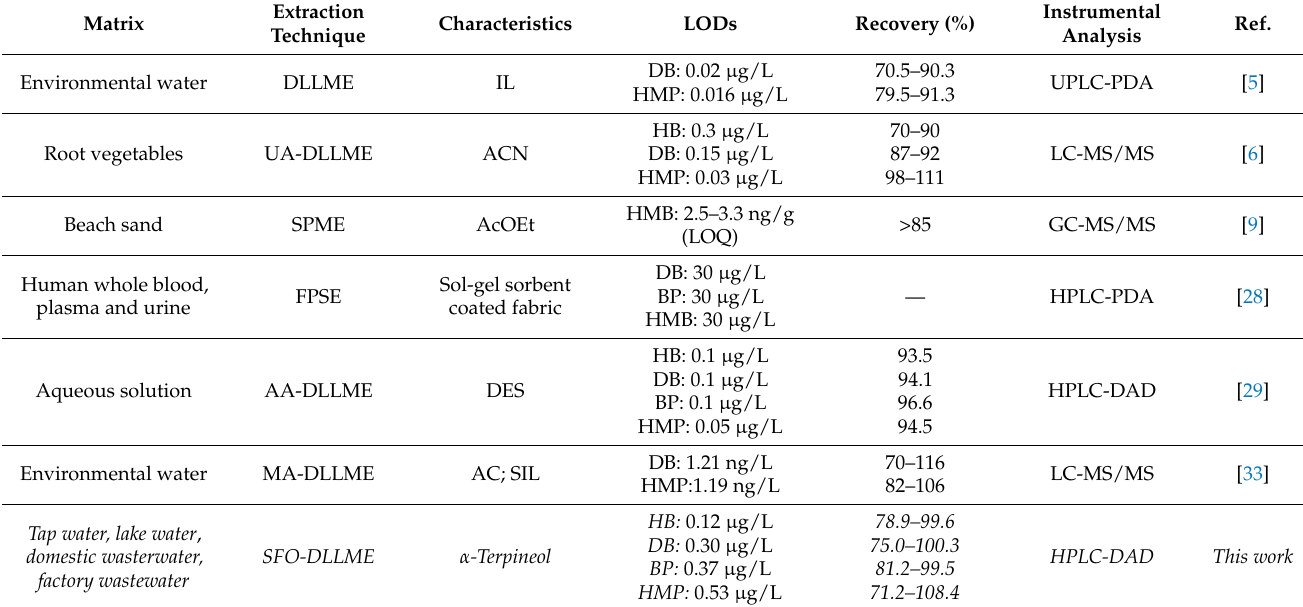
Table 4. Comparison with previous literature for the determination of four benzophenone com- pounds.